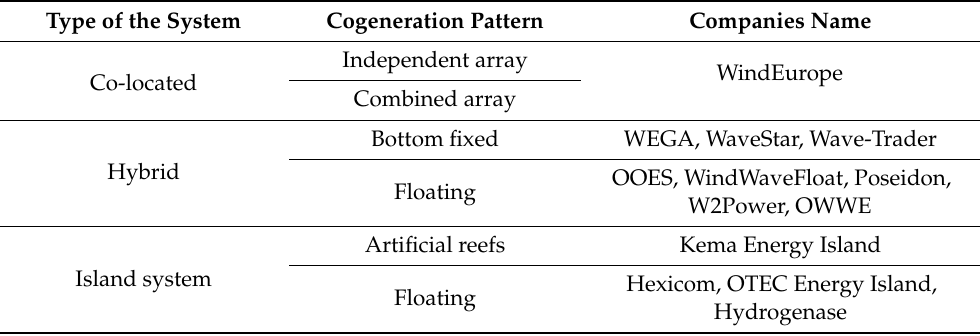
Table 4. The cogeneration pattern and the industry working on HOWWE. Adapted with permission from Ref. [8]. 2015,